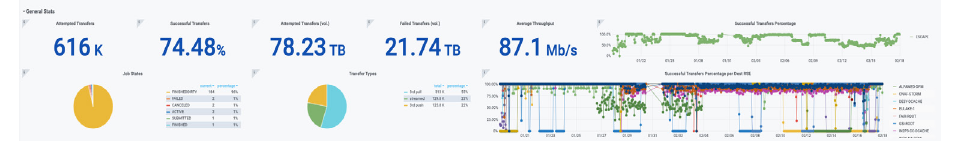
Figure 2: The Data Lake monitoring architecture